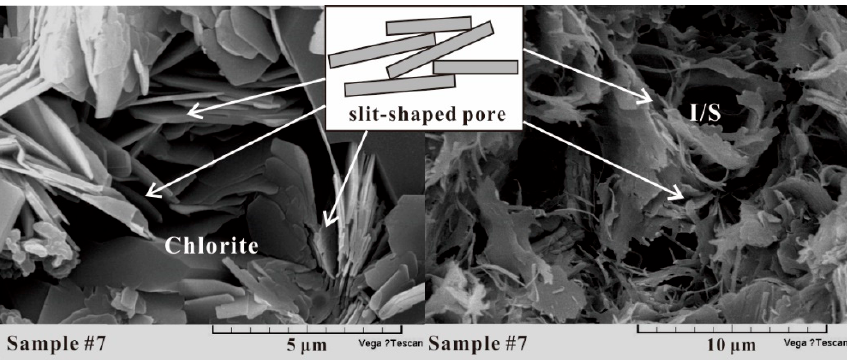
Figure 6. The slit-shaped pores related to the aggregates of plated-like clay minerals. Table 2. Pore structure properties derived from N 2 GA and RMIP experiments for nine tight rock samples in the Xujiaweizi Rift.